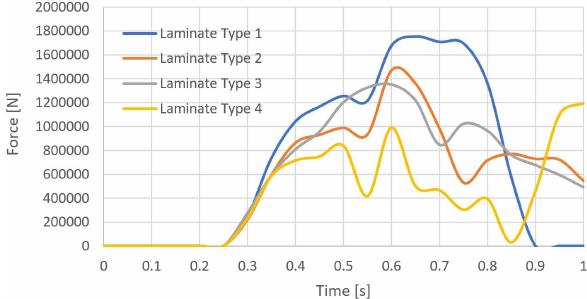
Figure 25: Force – Time of each type of laminate based on impact